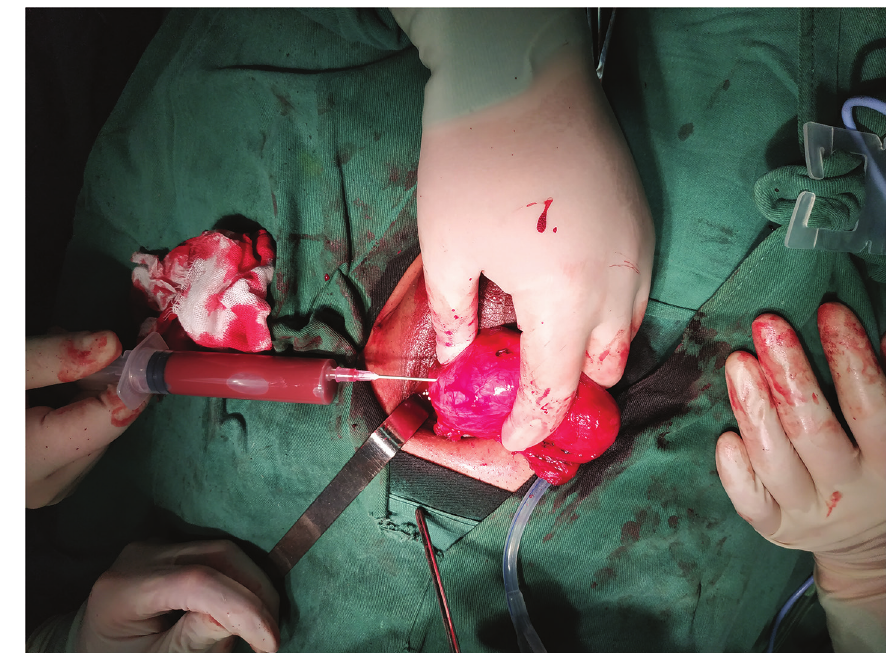
Figure 6. Aspiration of about 40ml of reddish brown purulent fluid with a syringe.